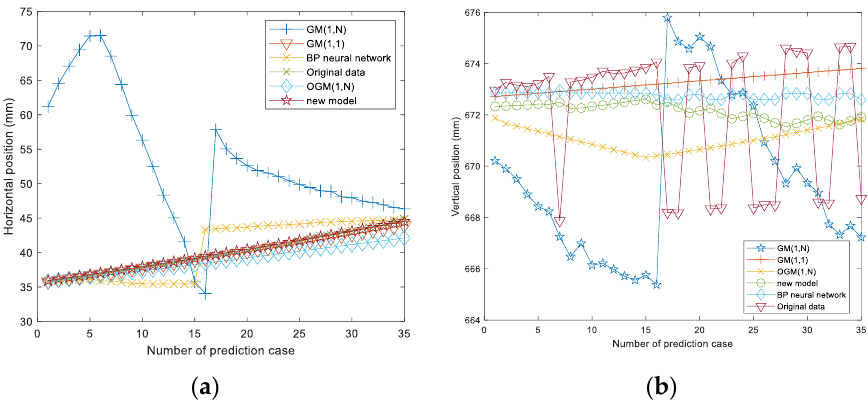
Figure 16. Curve of prediction for sensing unit 4. ( a ) Graph of horizontal displacement prediction effect of sensing unit 4. ( b ) Graph of vertical displacement prediction effect of sensing unit 4. Table 3. Comparison of prediction errors between different methods for different units.